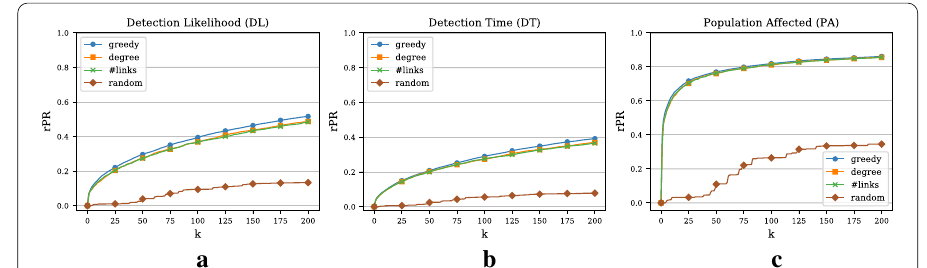
Fig. 2 Relative penalty reductions (rPR) and comparison with benchmarks (Example 1). a Relative penalty reduction for DL objective. The x-axis represents the size of the monitoring set k . We only plot the curves for the top 200 nodes. b Relative penalty reduction for DT objective. (c) Relative penalty reduction for PA